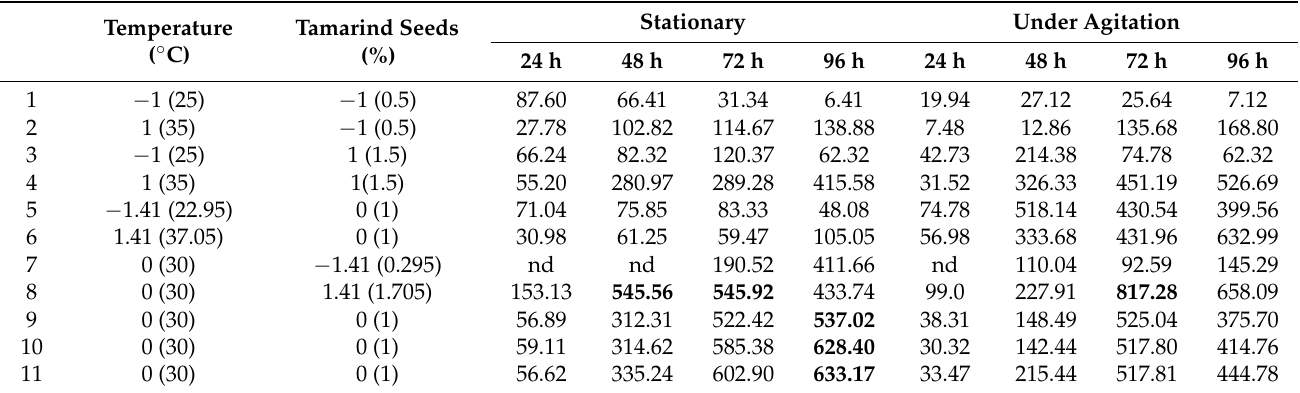
Table 2. XEG activity in the tests used for the construction of the experimental design for T. longi- brachiatum cultivated with tamarind